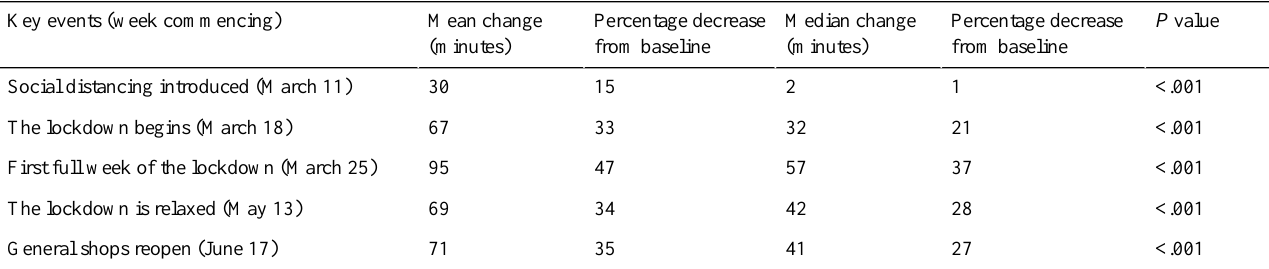
Table 4. Wilcoxon tests of change in physical activity from baseline to key weeks during the COVID-19 restrictions (January 22-June 17, 2020).